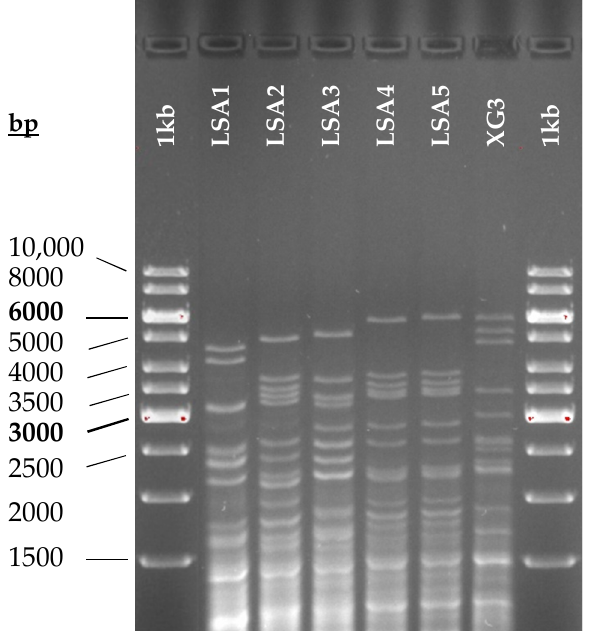
Figure 1. Genetic profile (mtDNA-RFLPs) of Saccharomyces cerevisiae strains used as inocula in this study. kb—1 kb DNA ladder molecular weight marker (Thermo Fisher Scientific, Madrid, Spain).